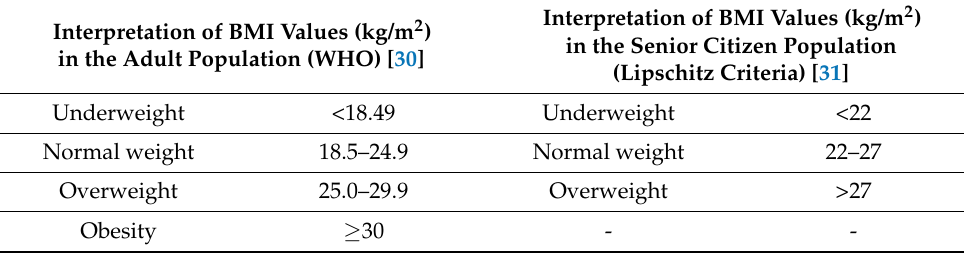
Table 3. Criteria for assessing nutritional status based on the Body Mass